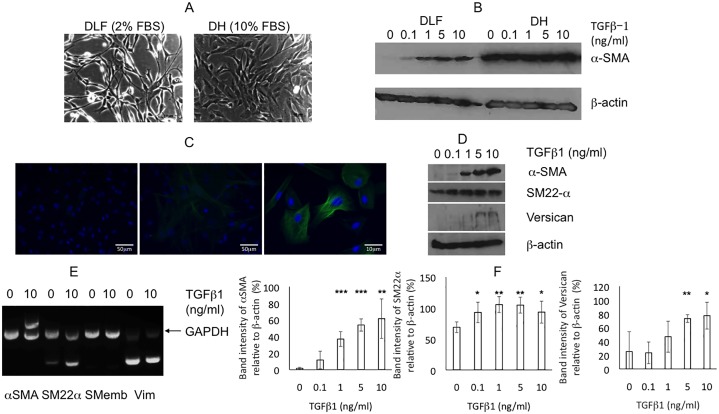
Quiescent valve interstitial cells (VIC) activated by TGFβ1.(A) Representative photomicrographs comparing morphology of normal VICs cultured in 2% (v/v) serum DLF and 10% (v/v) serum DH. Scale bar = 50μM. (B) Comparison of the expression of αSMA in low (DLF) and high serum (DH) conditions and in the presence of 0.1, 1, 5 or 10ng/ml TGFβ1. (C) Representative immunofluorescent photomicrographs of increased αSMA (green) expression in normal VICs in DLF (x20 magnification control left panel) treated with 10ng/ml TGFβ (x20 and x40 magnification centre and right panel respectively); blue DAPI staining showing cell nuclei. (D) Protein immunoblot for αSMA, SM22α and versican in DLF. (E) Representative RT-PCR for αSMA, SM22α, SMemb and vimentin (Vim) (gene specific primers multiplexed PCR with GAPDH housekeeping gene primers) in normal VICs untreated (0ng/ml) or treated (10ng/ml) with TGFβ1 in DLF. (F) Quantification of staining intensities relative to β-actin for αSMA, SM22α and versican respectively in normal VICs (n = 4) in DLF. Statistical analysis was performed with Student’s t-test. *, **, *** P<0.05, 0.01, 0.001 respectively.